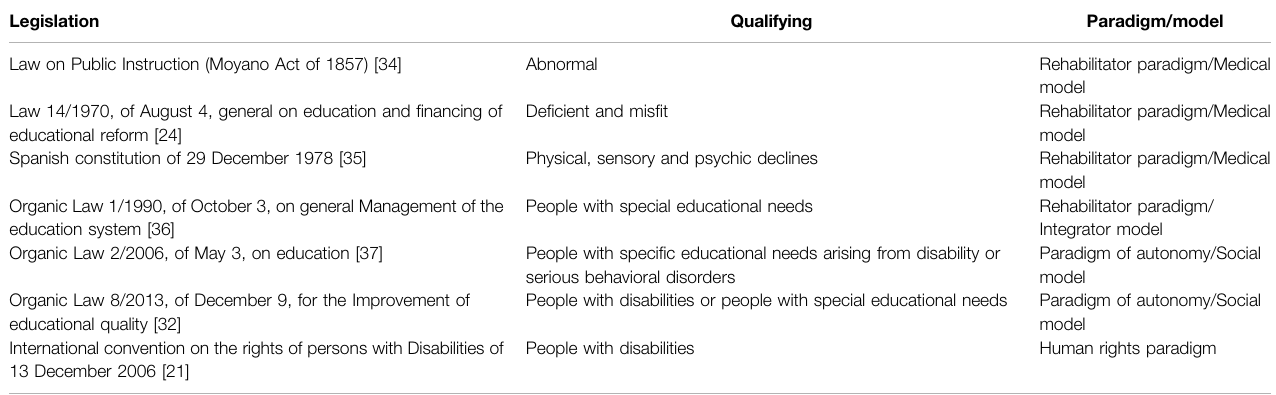
TABLE 3 | Evolution in the treatment of people with disabilities through Spanish educational